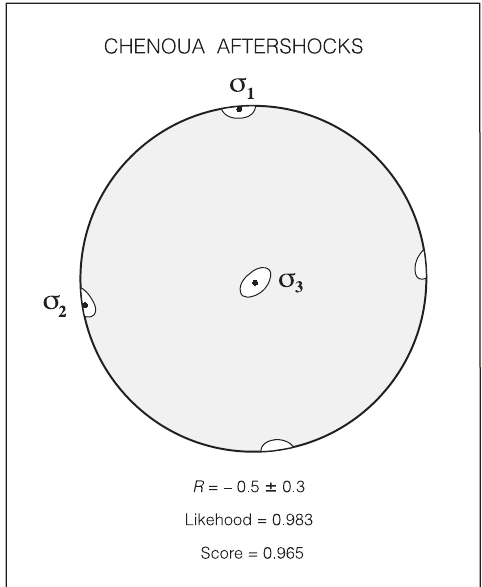
Fig. 8. Orientation of the principal axes of the stress tensor for the Chenoua aftershocks. The ellipses cor- respond to one standard deviation. Lower hemisphere equal area projection is